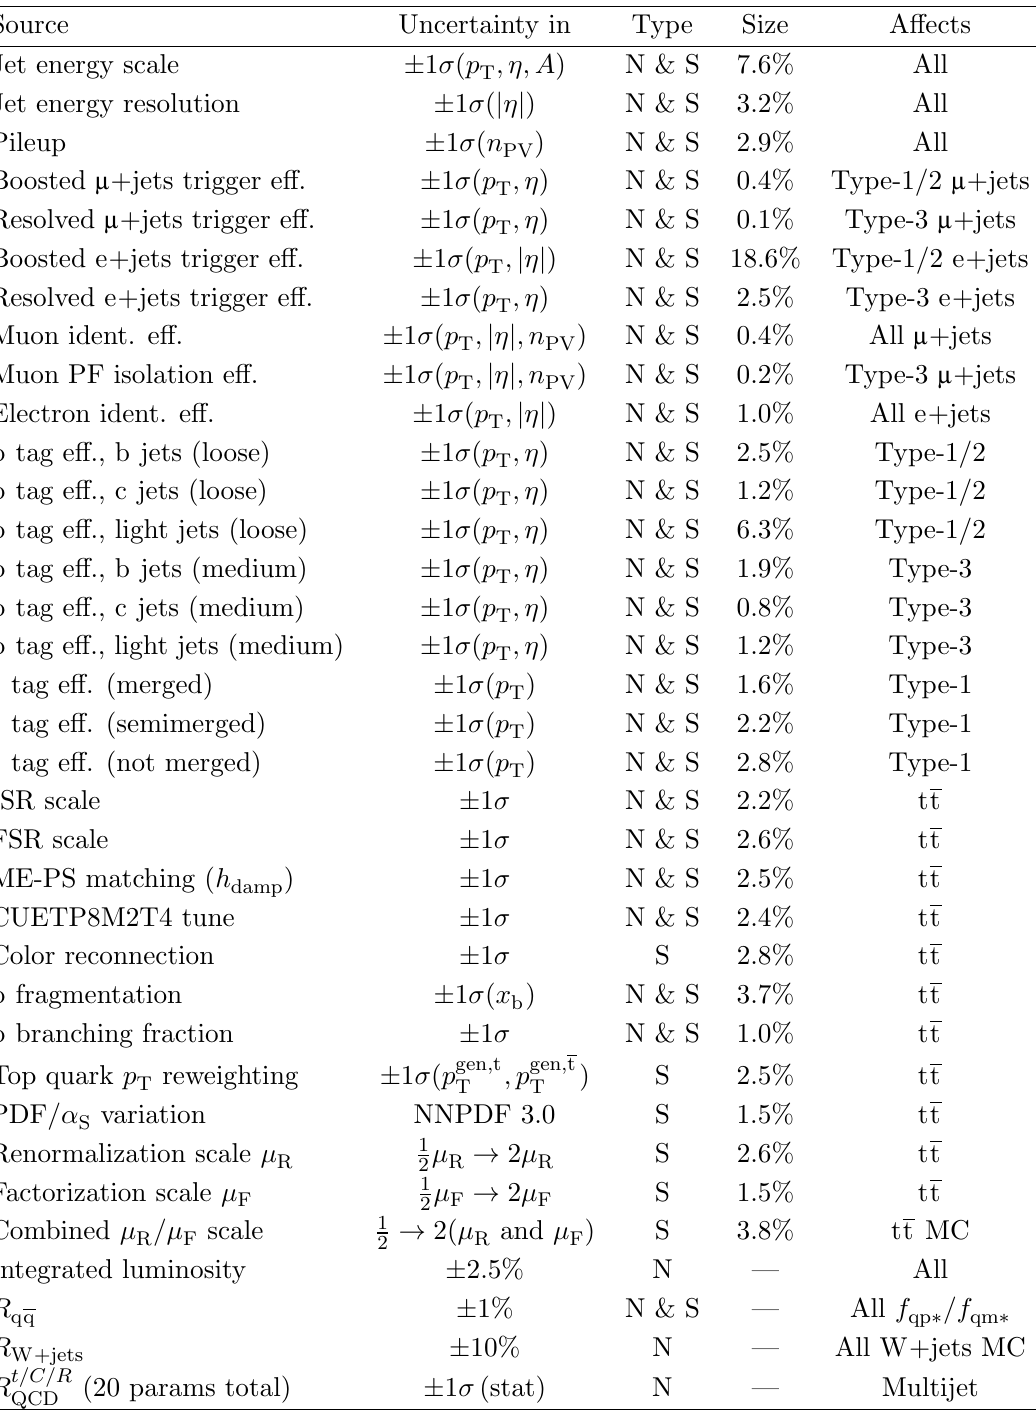
Table 2 . List of nuisance parameters considered in (cid:12)ts to data. The \N" stands for \normaliza- tion," and \S" for \shape" of the distribution in the \Type" column. The \Size" column lists the absolute value of the associated fractional shifts averaged over all a(cid:11)ected template bins. The quan- tities R t=C=R indicate that the QCD multijet yield uncertainties are independent in each topology, QCD channel, and